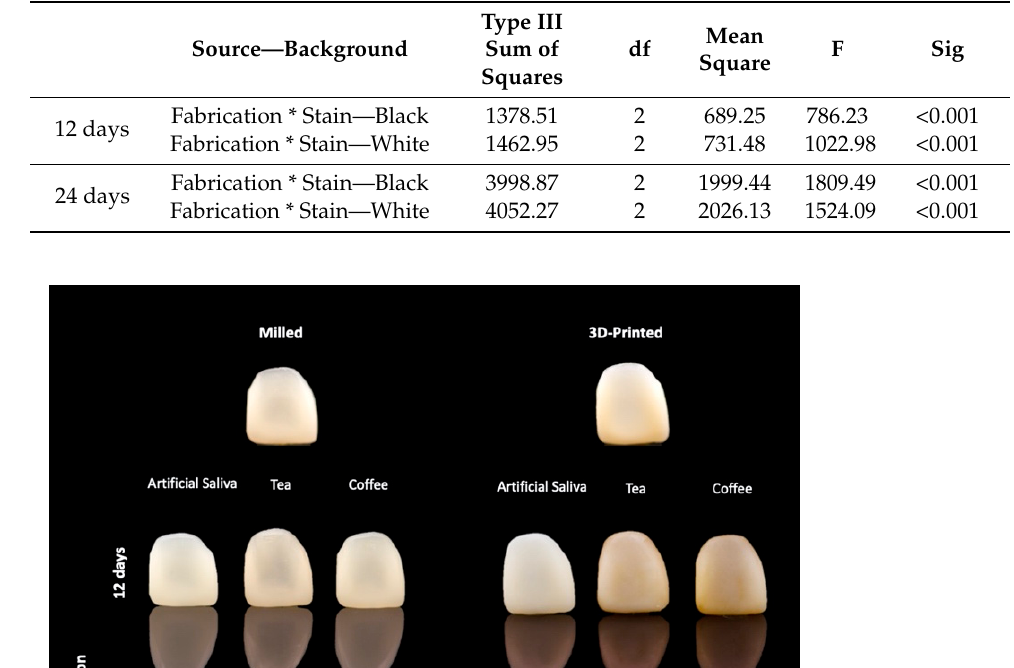
Table 2. Results of two-way ANOVA, interaction effect in black and white background for 12 and 24 days.